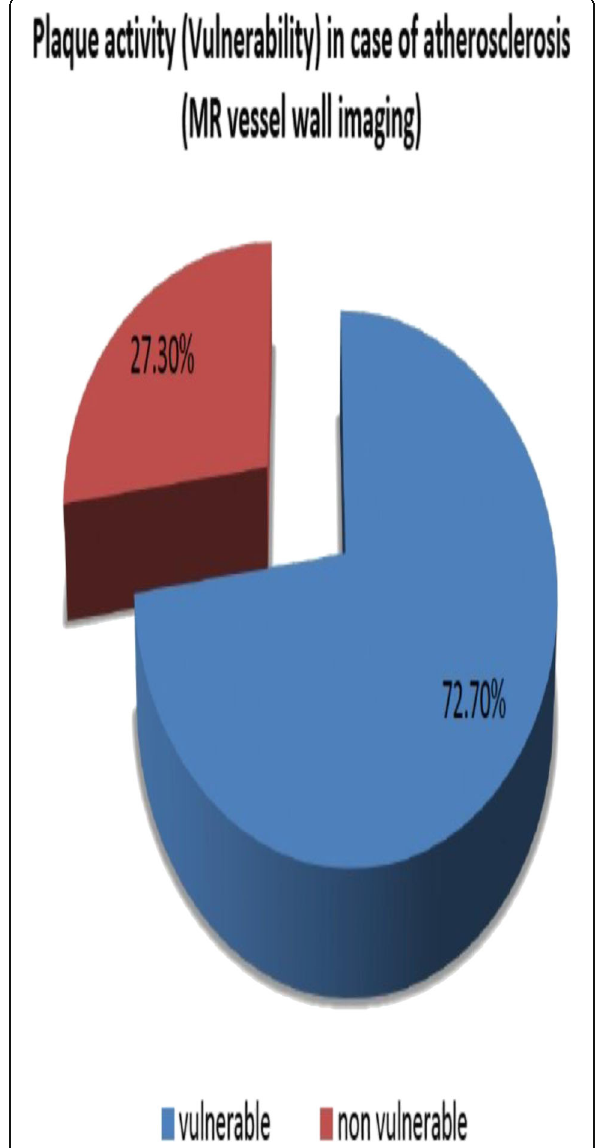
Fig. 4 Vulnerable vs non-vulnerable prevalence among the intracranial atherosclerotic